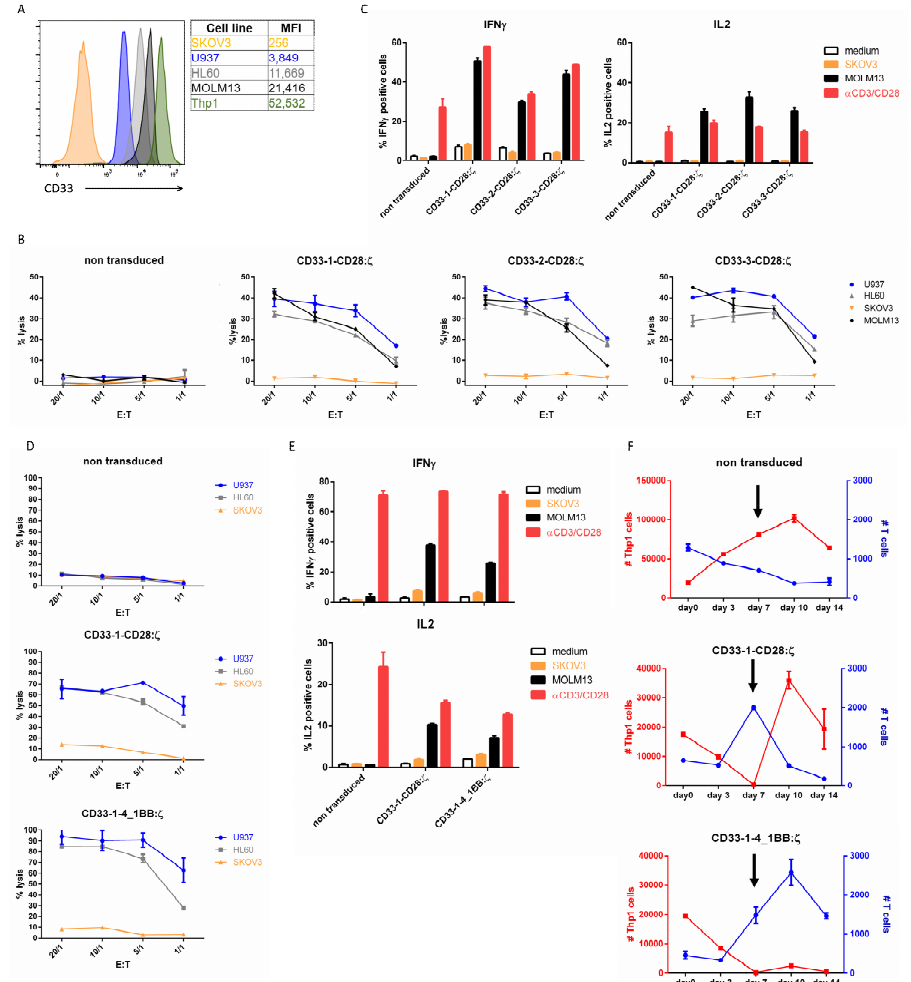
Figure 2. CD33-specific nanoCARs are functional: ( A ) CD33 surface expression on different target cell lines analyzed by flow cytometry. MFI represents median fluorescence index; ( B ) Cell lysis of CD33 + or CD33 - target cells after 4 h of co-incubation with T cells expressing the CD33-CD28:ζ nanoCAR in different effector-target ratios (E:T). Reported values are the means of duplicate determinations with error bars indicating the standard error of the mean (SEM); ( C ) Cytokine production of nanoCAR T cells was analyzed by intracellular staining 5 h after co-incubation with CD33 + or CD33 - target cells. Mean percentages of IFN-γ and IL-2 positive cells are shown, gated on eGFP + cells. Error bars indicate the SEM; ( D ) Cell lysis of CD33 + or CD33 - target cells after co-incubation with CD33-1-CD28:ζ or CD33-1-4_1BB:ζ nanoCAR T cells in different effector-target ratios. Reported values are the means of duplicate determinations. Error bars indicate the SEM; ( E ) Cytokine production of CD33-1-CD28:ζ or CD33-1-4_1BB:ζ nanoCAR T cells. Mean percentages of IFN-γ and IL-2 positive cells are shown. Error bars indicate the SEM; ( F ) Long-term in vitro stress test. NanoCAR T cells (blue) are incubated at very low (0.025:1) effector to target cell (red) ratios. Arrow indicates addition of fresh Thp1 cells at day 7. Error bars represent the SEM. The data are representative of two independent experiments with three different donors. Each experiment shown was performed two times with three different donors. Data shown are representative for these experiments.